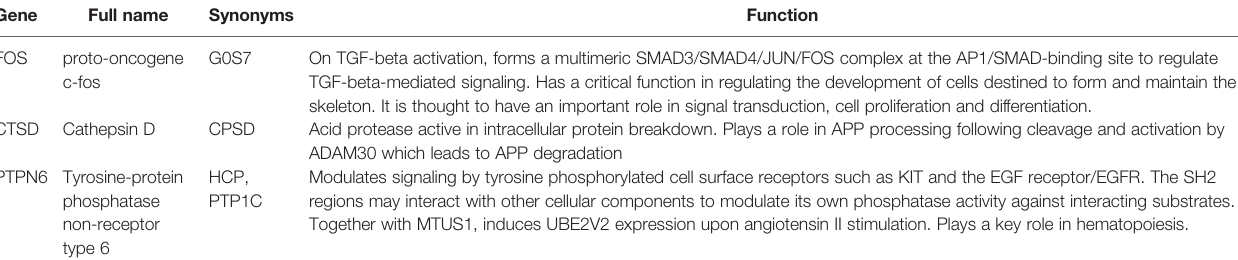
TABLE 3 | Description of the Hub